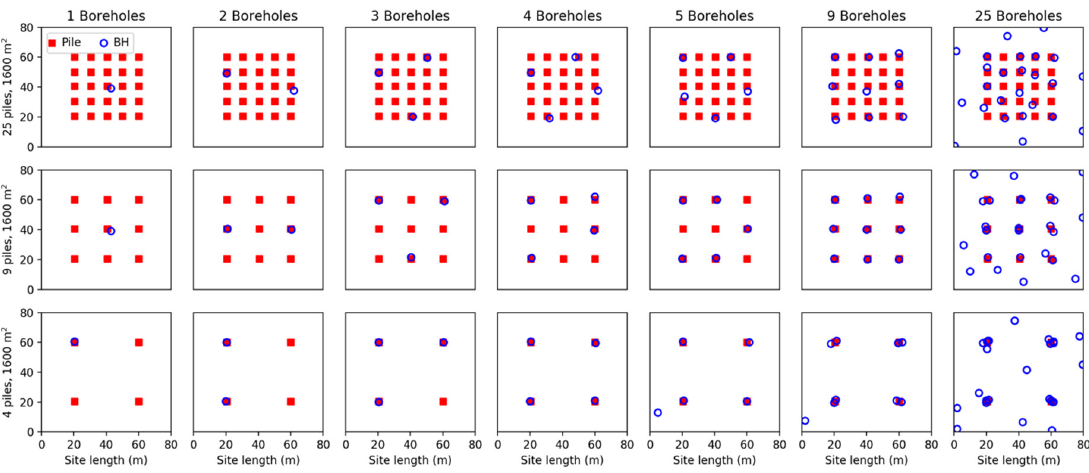
Figure 6. Failure cost comparison between borehole (BH) patterns; a regular grid (Grid) and optimal locations (Opt.) for different numbers of piles, and an SOF of ( a ) 10 m, ( b ) 15 m, and ( c ), 20 m.